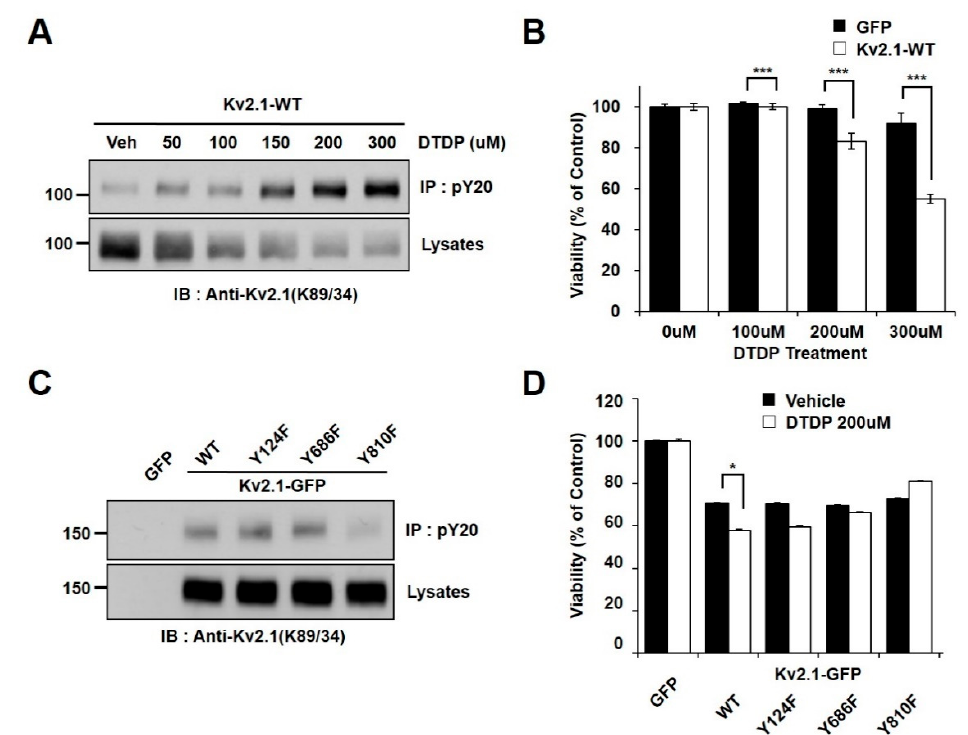
Figure 1. Tyrosine phosphorylation of the K v 2.1 channel is induced by DTDP treatment. ( A ) The concentration-dependent effect of DTDP on K v 2.1 tyrosine phosphorylation. HEK293 cells were transfected with the K v 2.1 plasmid. Immunoblot showing that tyrosine phosphorylation levels of the K v 2.1 channel protein are induced in a concentration-dependent manner (0–300 µM) by DTDP treatment. ( B ) Cell viability assay demonstrating the effect of DTDP in HEK293 cells expressing either GFP (black bar) or K v 2.1 (white bar). ( C ) HEK293 cells were transfected with K v 2.1-WT or tyrosine mutants (Y124F, Y686F, or Y810F). No difference was detected between the WT and mutants for the expression of the K v 2.1 channel after DTDP treatment (200 µM). The Y810 mutation decreased tyrosine phosphorylation of K v 2.1. ( D ) Cell viability assay showing the mean effect of DTDP (200 µM) on viability in HEK293 cells expressing the K v 2.1-WT or K v 2.1 mutations. Data are expressed as the